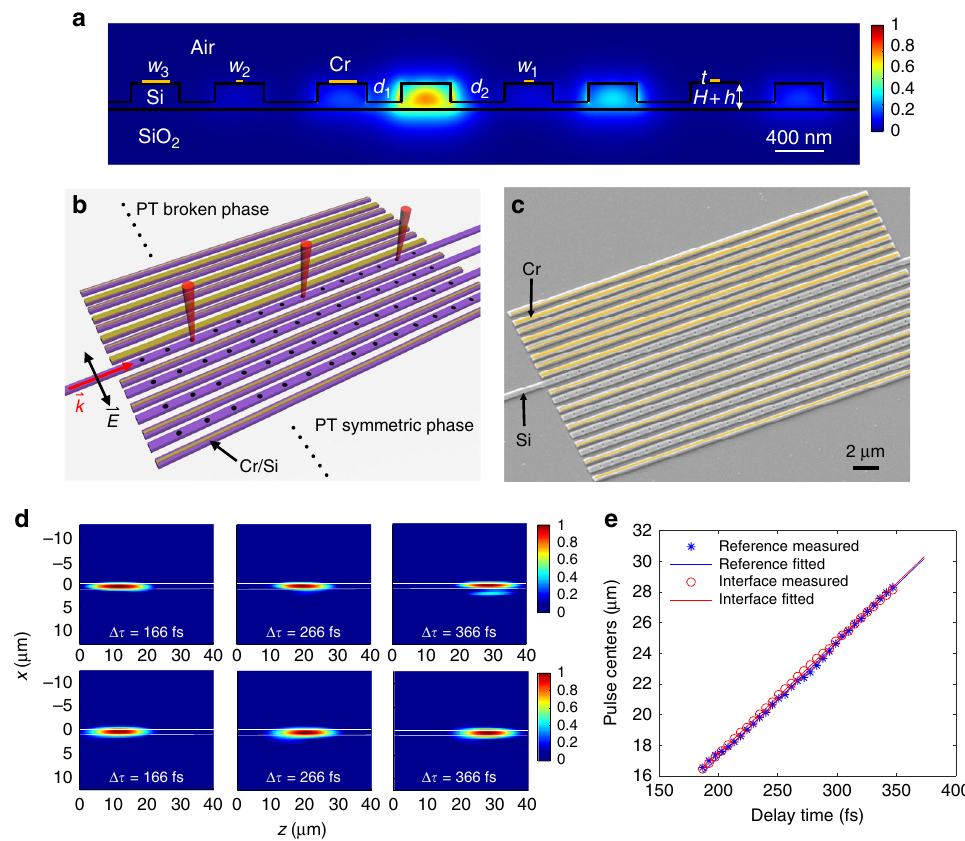
Fig. 2 Observation of the zero mode on a photonic platform. a Cross section of the amplitude distribution in the tight-binding binary waveguide array to realize the phase transition and its induced zero mode at the interface. The width and height of the ridge waveguides are W = 400 nm, H = 150 nm and h = 70 nm, respectively. The coupling between waveguides is controlled by the separation between waveguide, where d and d 2 = 450 nm for t B = 0.0324 μ m − 1 , for the operation wavelength of 1550 nm. The onsite damping is implemented by Cr depositions on top of waveguides with a uniform thickness of t = 20 nm but varied widths: w 1 = 90 nm to create 2 γ = 0.0811 μ m − 1 in the right PT symmetric semi-lattice, while w = 80 nm and w = 350 nm to create 2 γ = 0.2838 μ m − 1 in the left PT broken semi-lattice. The waveguide lattice can then be viewed as a collection of 2 3 coupled dimers, where t A and t B alternates. The eigen-mode simulation shows the fi eld distribution of the interface state with an effective index of n 0 = 2.37 at 1550 nm. b Schematic of the waveguide array sustaining the zero mode at the transition interface between the PT broken and symmetric semi- lattices, where the zero mode is excited by directly coupling quasi-TE polarized light into the interface waveguide. A set of periodic radiation holes are introduced on the top of the lossless waveguides to scatter light for far- fi eld observations. c The SEM picture of the loss modulated PT waveguide array on an SOI platform, where pseudo yellow color denotes the Cr depositions on top of waveguides. d The same propagation lengths can be observed for the intensity distributions of the carried zero mode (upper panel) and a single waveguide control (bottom panel) at different time delays of 166, 266, and 366 fs. The middle/single waveguides are marked with solid lines. e The relation of the center of the wave packet traveling in time, where dots and lines represent raw measurement data and their corresponding linear fi ttings. The consistence between the interface mode (red) and the single waveguide mode (blue) evidently demonstrates the zero-energy